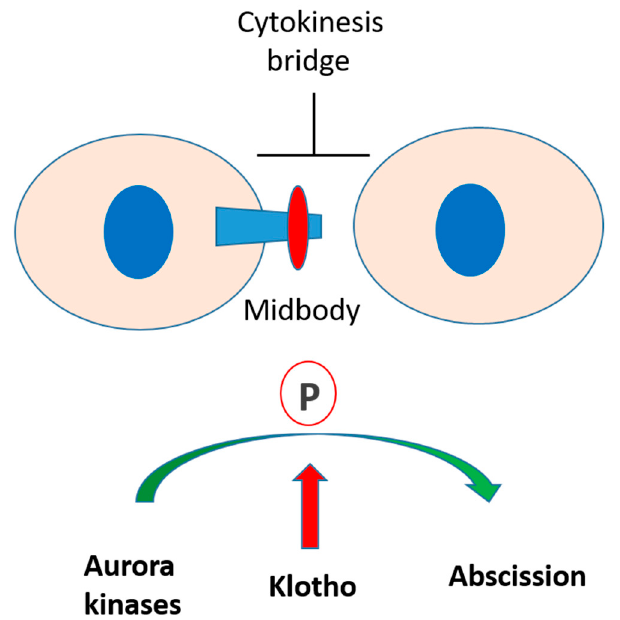
Figure 9. Putative roles of Klotho in cytokinesis. Klotho is essential for cytokinesis by regulating Aurora kinase activation. Klotho depletion inhibits Aurora kinase activation and results in impaired cytokinesis bridge abscission.